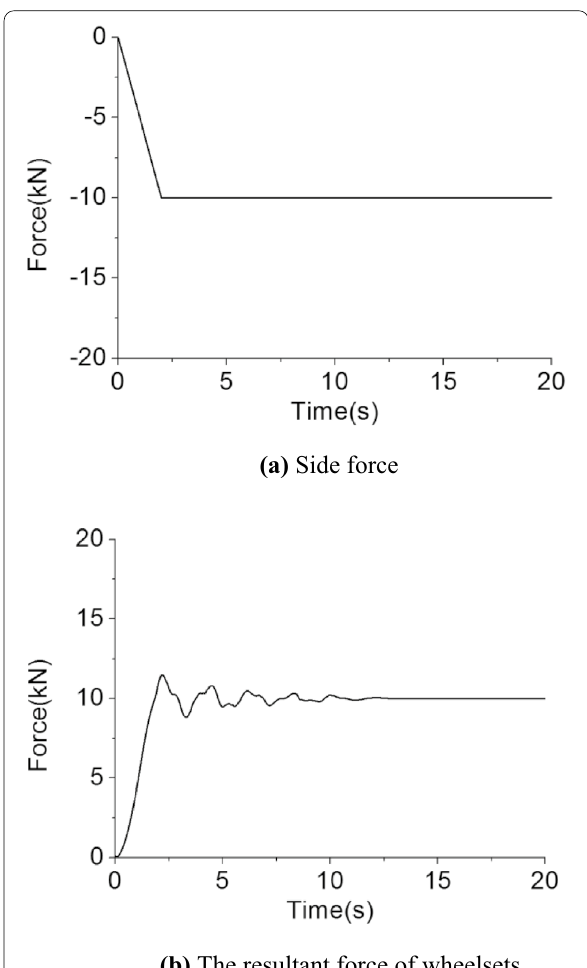
(b) The resultant force of wheelsets Figure 8 Aerodynamic load